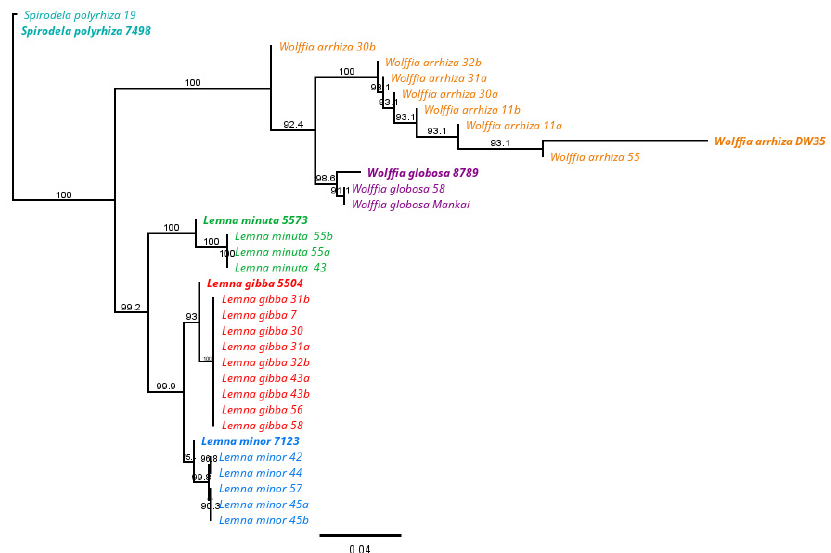
Figure 2. Neighbor-Joining tree using the concatenated psbK - psbI and atpF - atpH sequences and the Tamura-Nei distance. Based on 1000 reiterations. The numbers on the nodes represent the percentage of bootstrap values. Horizontal bars indicate genetic distances. Reference sequences were retrieved from the NCBI database and highlighted in